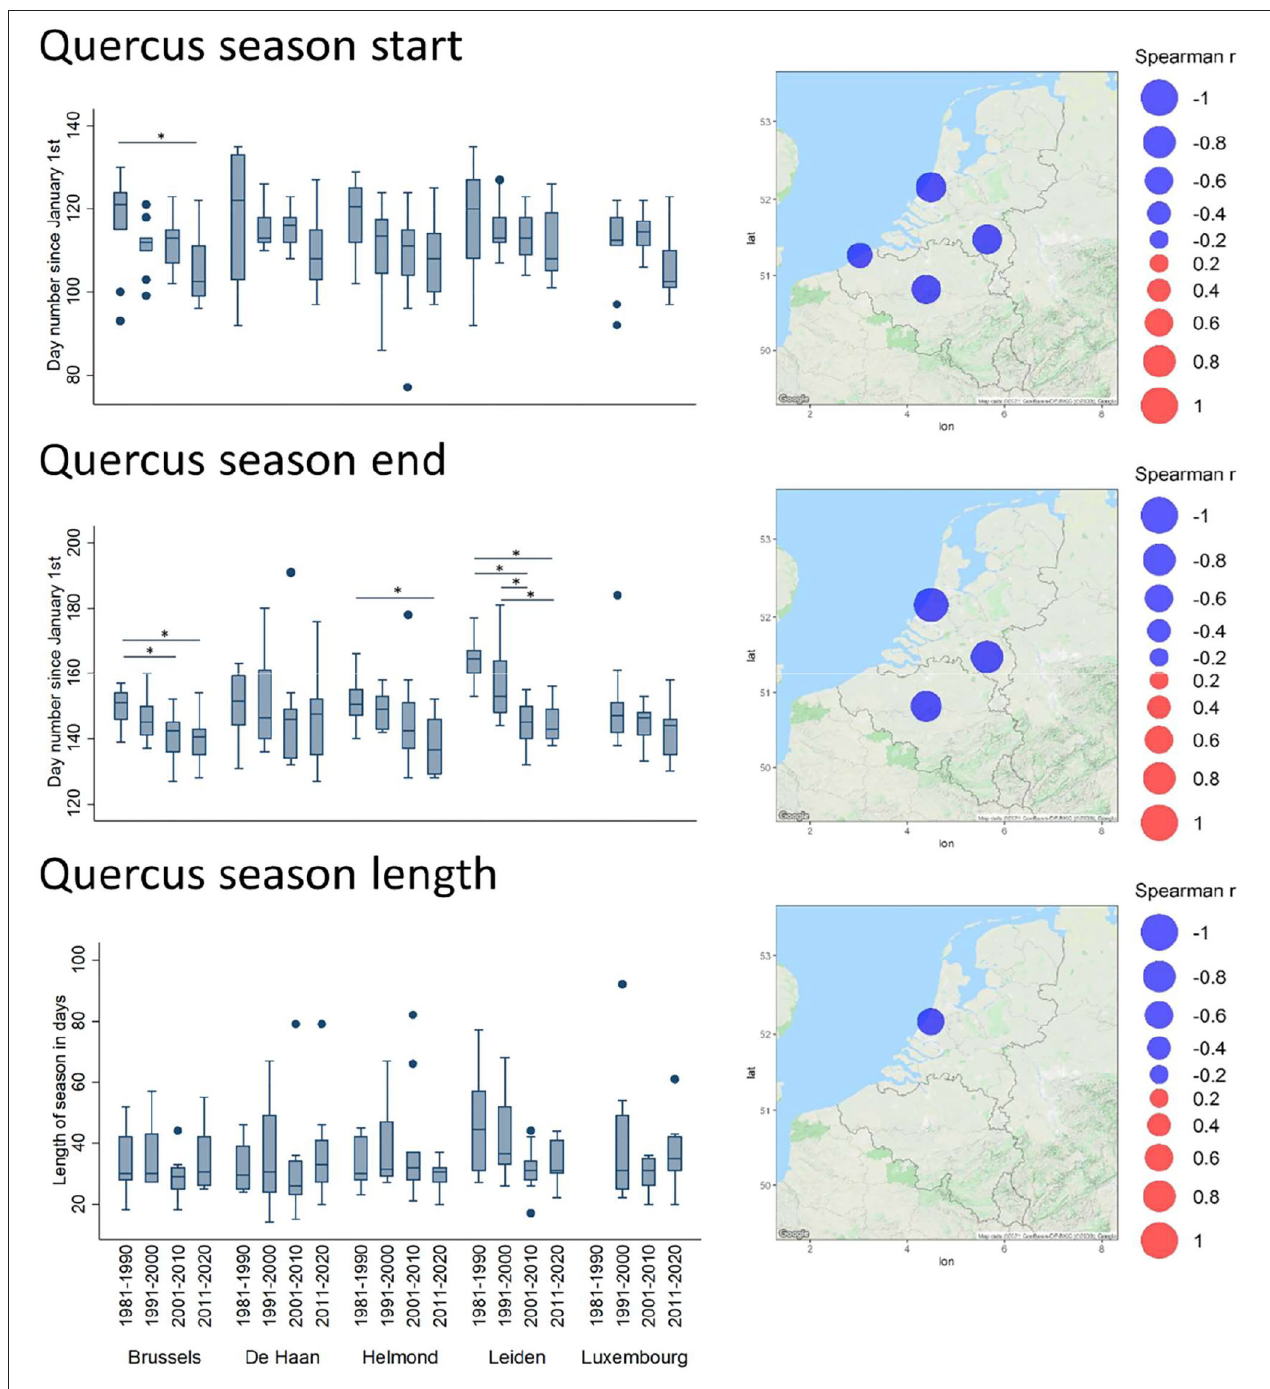
FIGURE 5 | Trends of timing shifts in pollen seasons for Poaceae. For further details see, legend of Figure 4 .